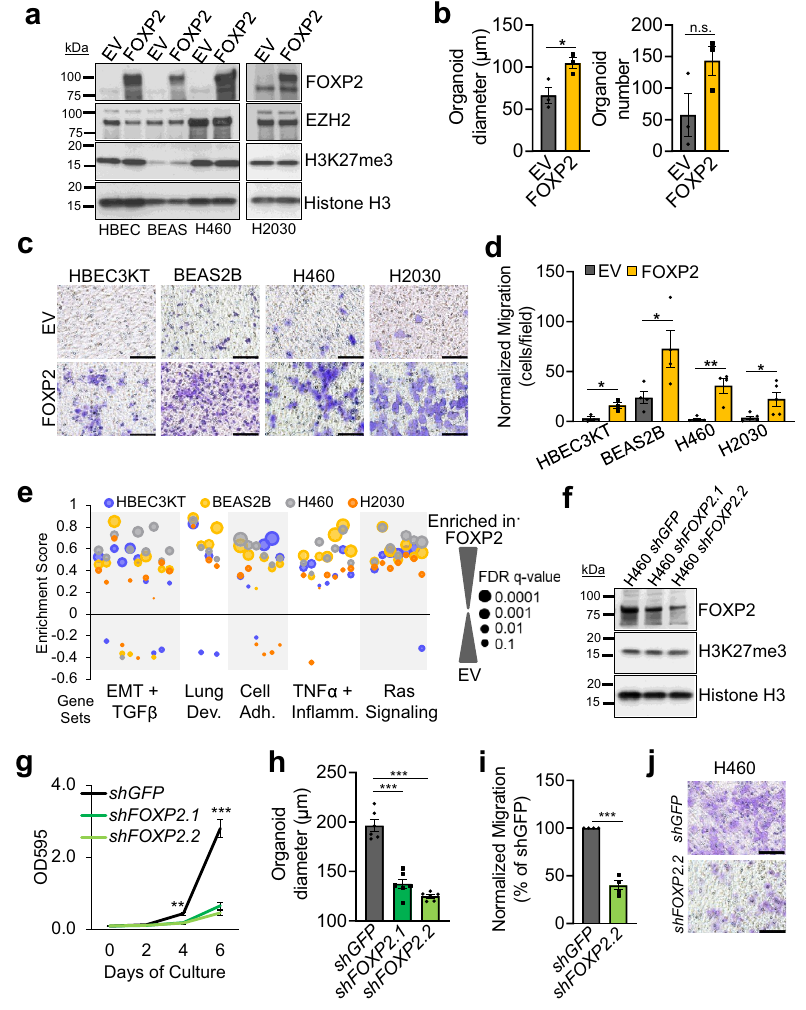
Fig. 5 | FOXP2 drives stemness and migration in lung epithelial cells. a FOXP2 protein expression in HBEC3KT, BEAS2B, H460, and H2030 cells transduced with FOXP2lentiviruswasexaminedbyimmunoblot.EVistheemptyvectorcontrolline. b AveragediametersandorganoidcountsofBEAS2B3Dorganoidswithorwithout FOXP2 overexpression plotted as mean values +/ − SEM. * indicates P =0.034 by two-tailed t test. n =3 individual cell cultures per group. c Representative images, scale bar=100 µ m, and d average numbers of migratedcells normalized to growth rates in HBEC3KT, BEAS2B, H460, and H2030 cells with or without FOXP2 over- expressionplottedasmean+/ − SEM.*indicates P <0.047,**indicates P =0.0041by two-tailed t test. n =3, 4, 5, 5 for HBEC3KT, BEAS2B, H460, H2030 individual cell culturespergroup,respectively. e Rank-orderedgenelistswerequeriedagainstthe MSigDB databases and enrichment scores of selected gene signatures enriched in FOXP2overexpressingcelllinesrelativetoEVlineswereplotted.Dotsizeestimates FDR.DataaresummarizedinSupplementaryTable7. f FOXP2proteinexpressionin 2D H460 cells transduced with the indicated small hairpins was examined by